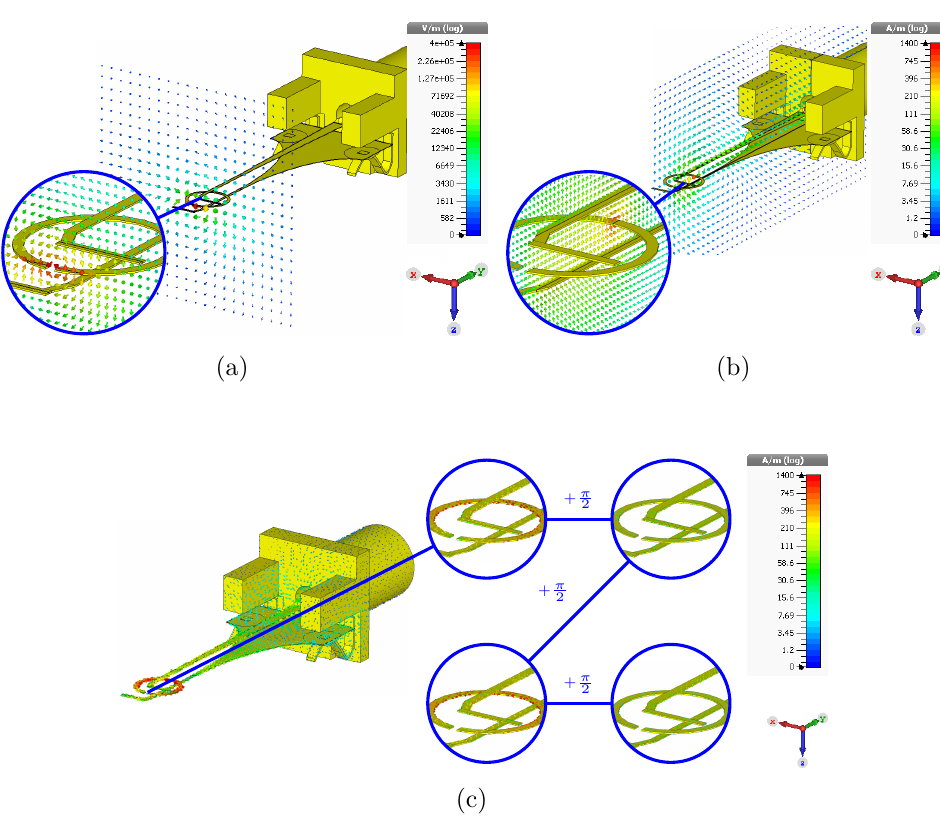
Figure 3. ( a ) Electric field in the x - z cutting plane through the dipole antenna and the split-ring resonator (SRR). The zoom-in section highlights the electric field in the SRR gap region; ( b ) Magnetic field in the y - z cutting plane through the dipole antenna and the split-ring resonator (SRR). The zoom-in section highlights the magnetic field through the SRR; ( c ) Simulated surface current of the dipole antenna with SRR. The four zoom-in sections depict the surface currents. Each zoom-in section displays the current at phase steps of π for a complete oscillation cycle. 2